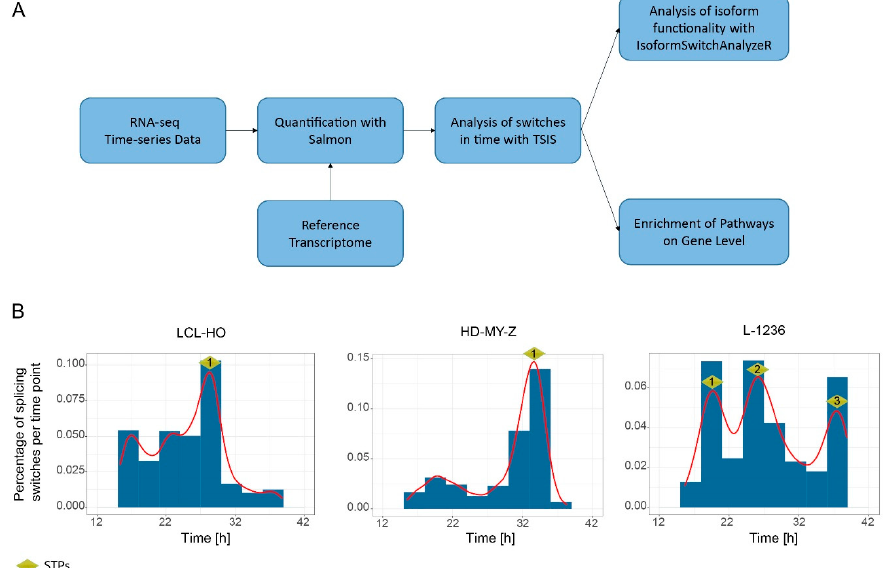
Figure 1. Analysis of isoform expression switching over time shows an enrichment of switching events in a time-specific manner ( A ) Schematic representation of the pipeline for the detection and analysis of isoform switching events. ( B ) Distribution of isoform-switching events for all genes over time. The LCL-HO cell line shows only one switch time peak (STP) between 27 h and 30 h ( STP1, 273 switching events), the HD-MY-Z cell line shows a STP between 33 h and 36 h (STP1, 783 switching events) and the L-1236 cell line shows three STPs between 18 h to 21 h (STP1, 166 switching events), 24 h to 27 h (STP2, 167 switching events) and 36 h to 39 h (STP3, 148 switching events).